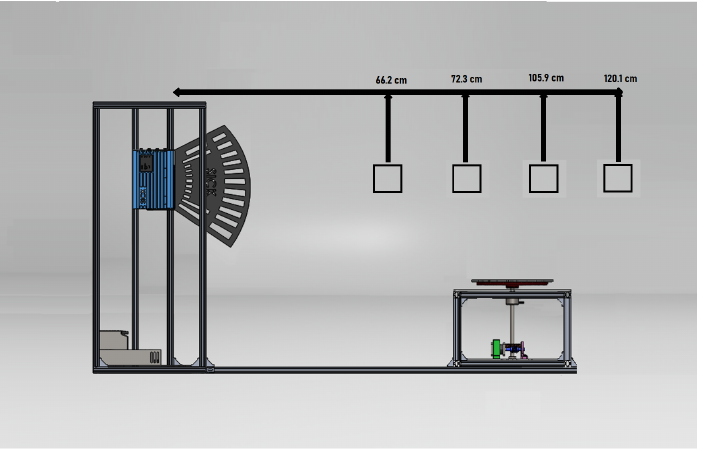
Figure 8. Diagram of the lengths used to measure the precision were measured with the proposed